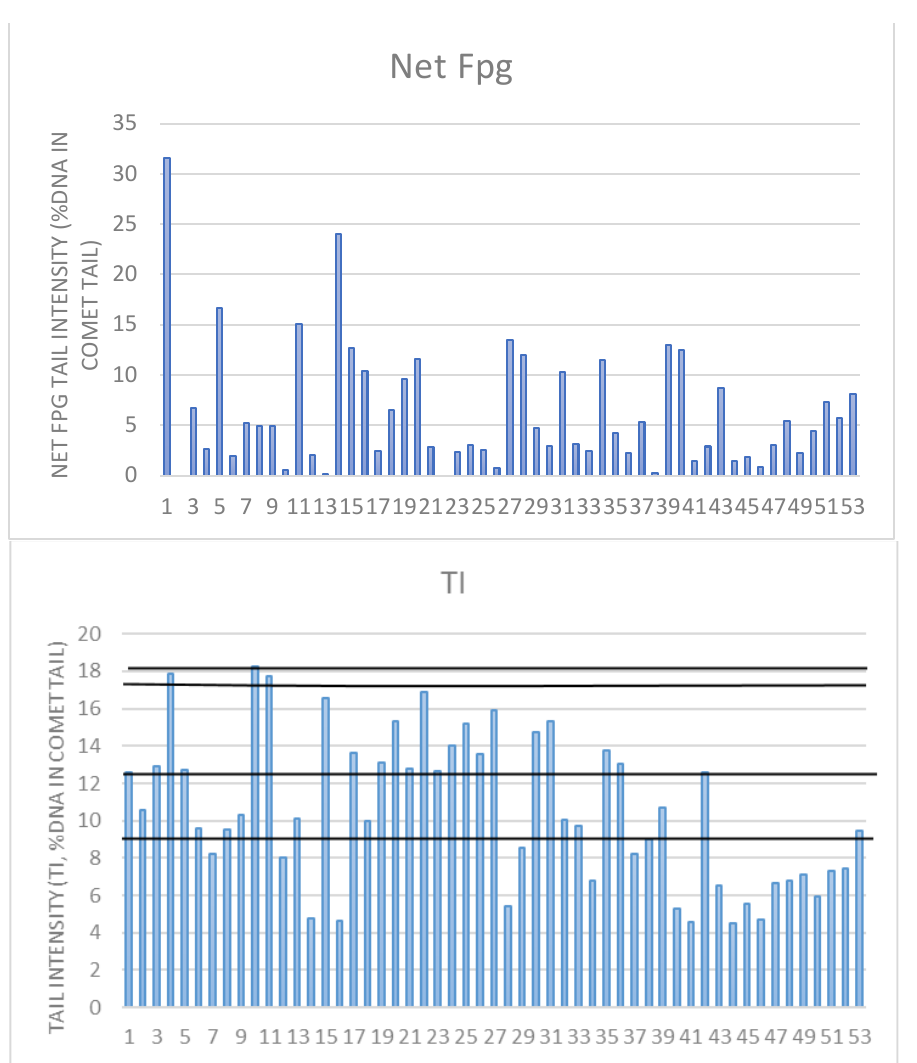
Figure 5. Individual DNA damage for Fpg and alkaline comet assay TI parameters. For Net Fpg TI, there is no reference value for oxidative damage; the mean value for the entire group was 6%. We demonstrated before that alive and healthy individuals have up to 9% of TI, cancer-free up to 12.4%, cancer cases 17.7%, and deceased 18%. The highest value in this study group was below 18% (tail